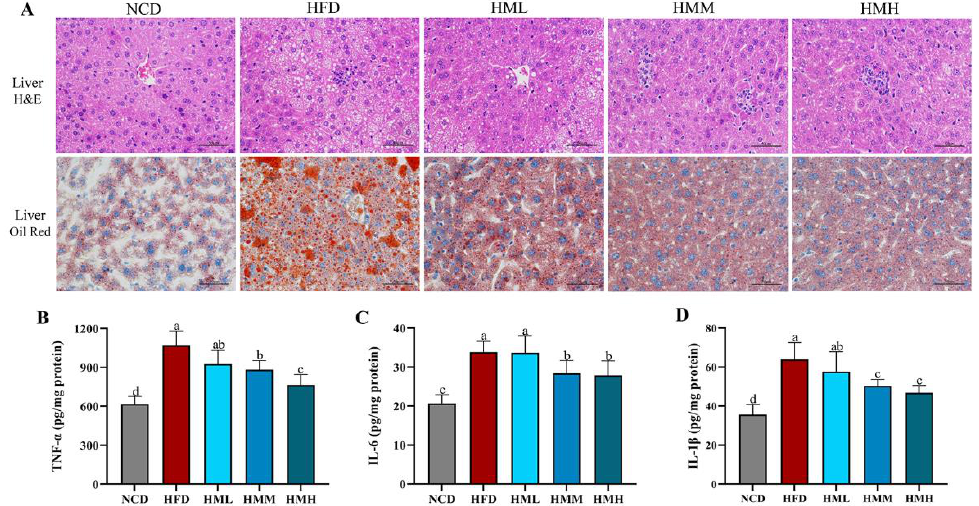
Figure 3. Effects of matcha on hepatic lipid infiltration and inflammation. ( A ) Morphology of liver sections stained with oil red O and hematoxylin-eosin (H&E) staining; ( B – D ) levels of major inflammatory cytokines (TNF- α , IL-6, and IL-1 β ) determined by ELISA. Data are expressed as means ± SEM ( n = 5). Means with different letters (a–d) were considered significantly different at p < 0.05 according to Tukey’s test.